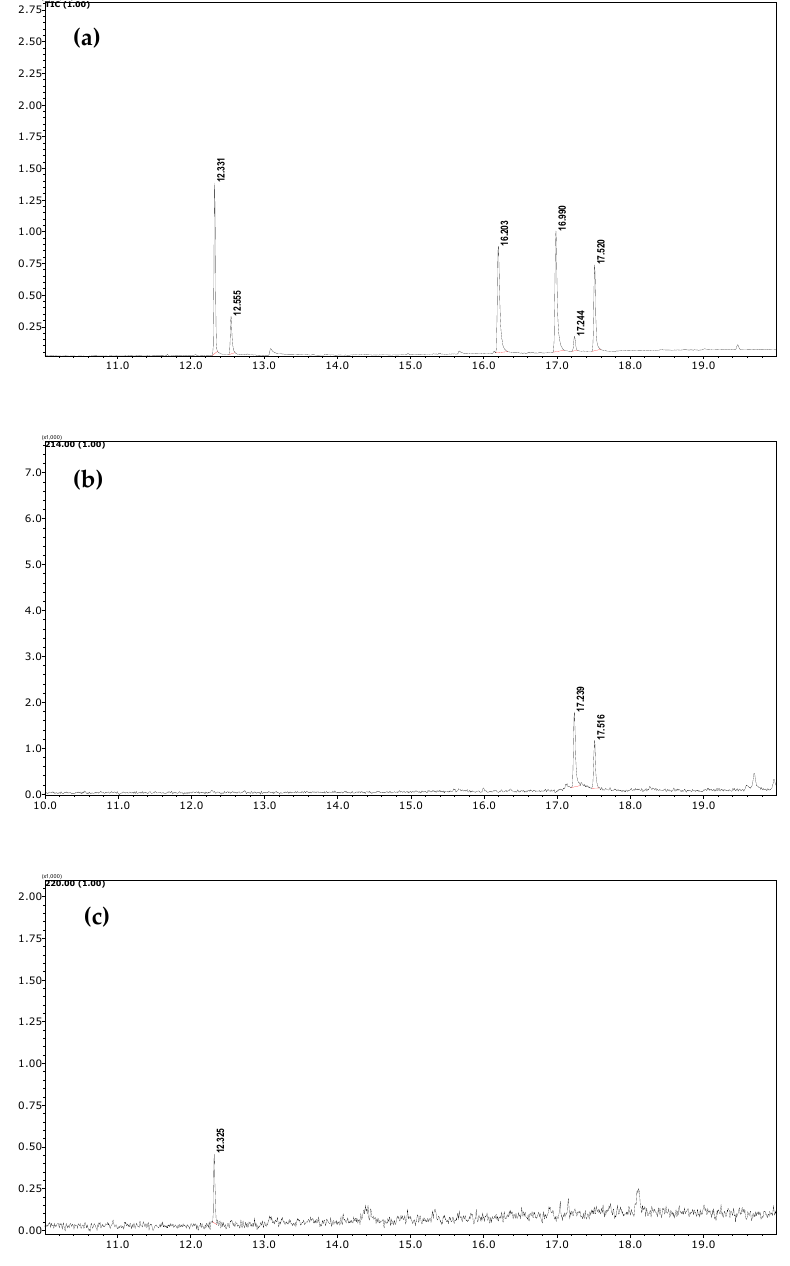
Figure 4. ( a ) TIC of standard sample at 10 µg mL − 1 ( b ) SIM chromatogram of urine sample of donor who had consumed DICL; ( c ) SIM chromatogram of urine sample of donor who had consumed IBU.